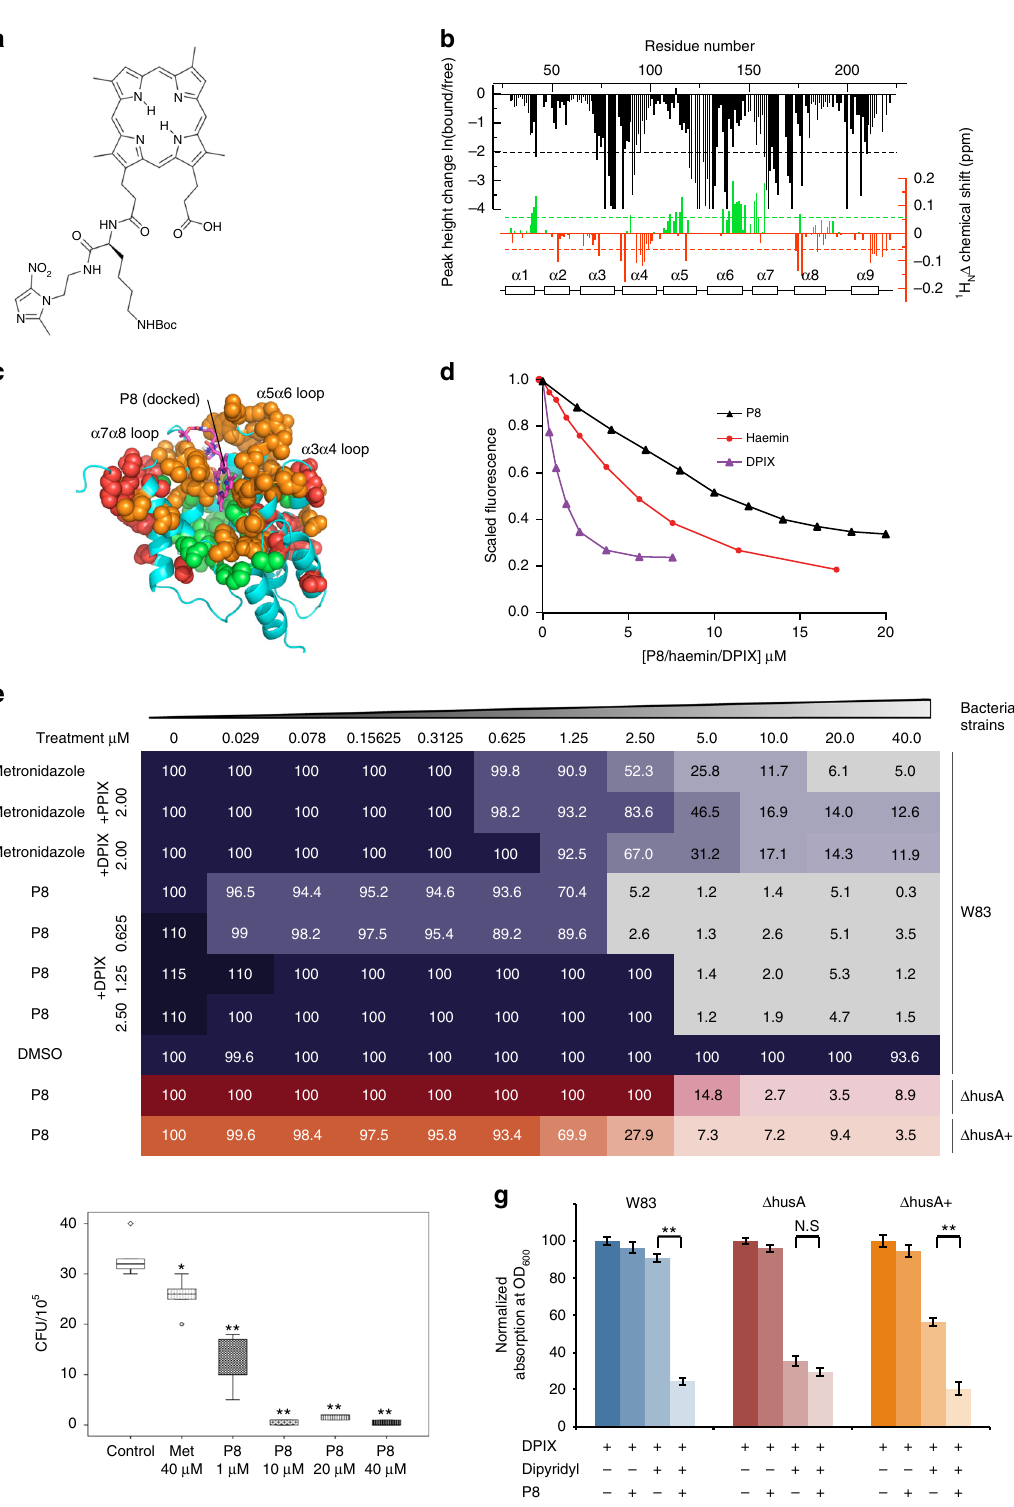
conformer set 1, due to reorientation of side chains around the binding site as part of the docking algorithm (Supplementary Figure 20a). Docked ligands consistently adopted π -stacking interactions with the benzene ring of F80 on one side of the porphyrin ring, and/or π -stacking or edge-to-face stacking with the phenol ring of Y164 on the opposite side of the porphyrin (Fig. 2g). A cluster of Ser115, Ser119, Ser137 and Ser161